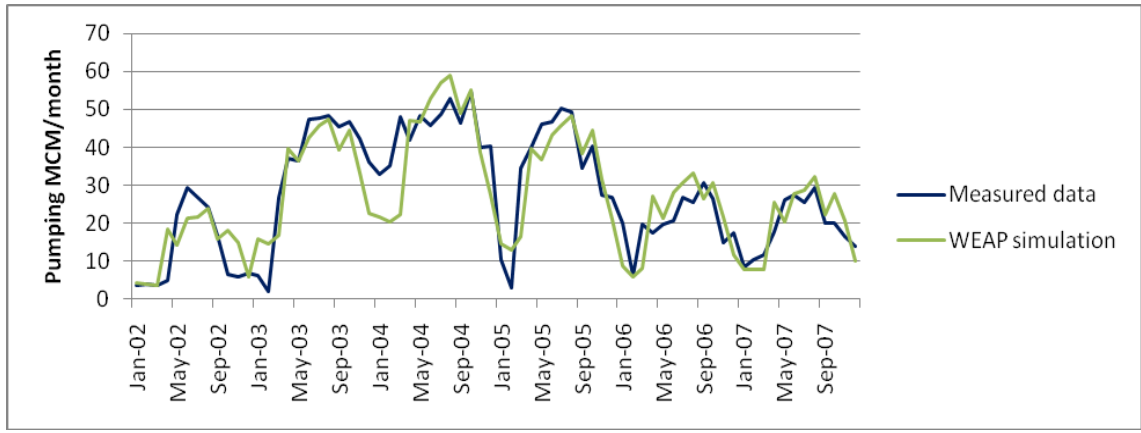
Figure 3. Comparison of WEAP simulated vs . measured pumping by the NWC (in million cubic meters–MCM per